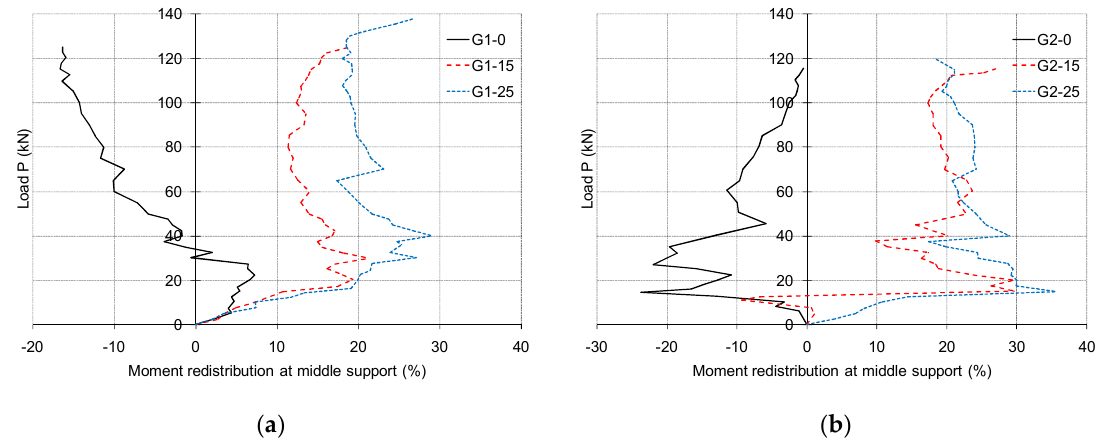
Figure 7. Load–moment redistribution relationship in the middle support section for experimental beams: ( a ) series 1; ( b ) series 2.